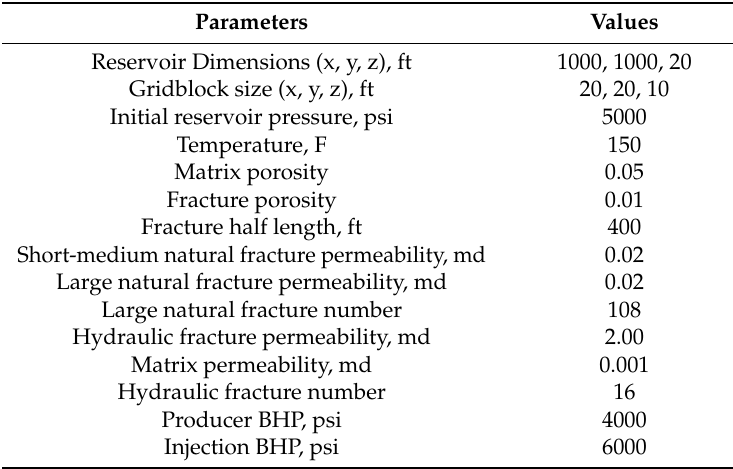
Table 2. Parameters of the base model.